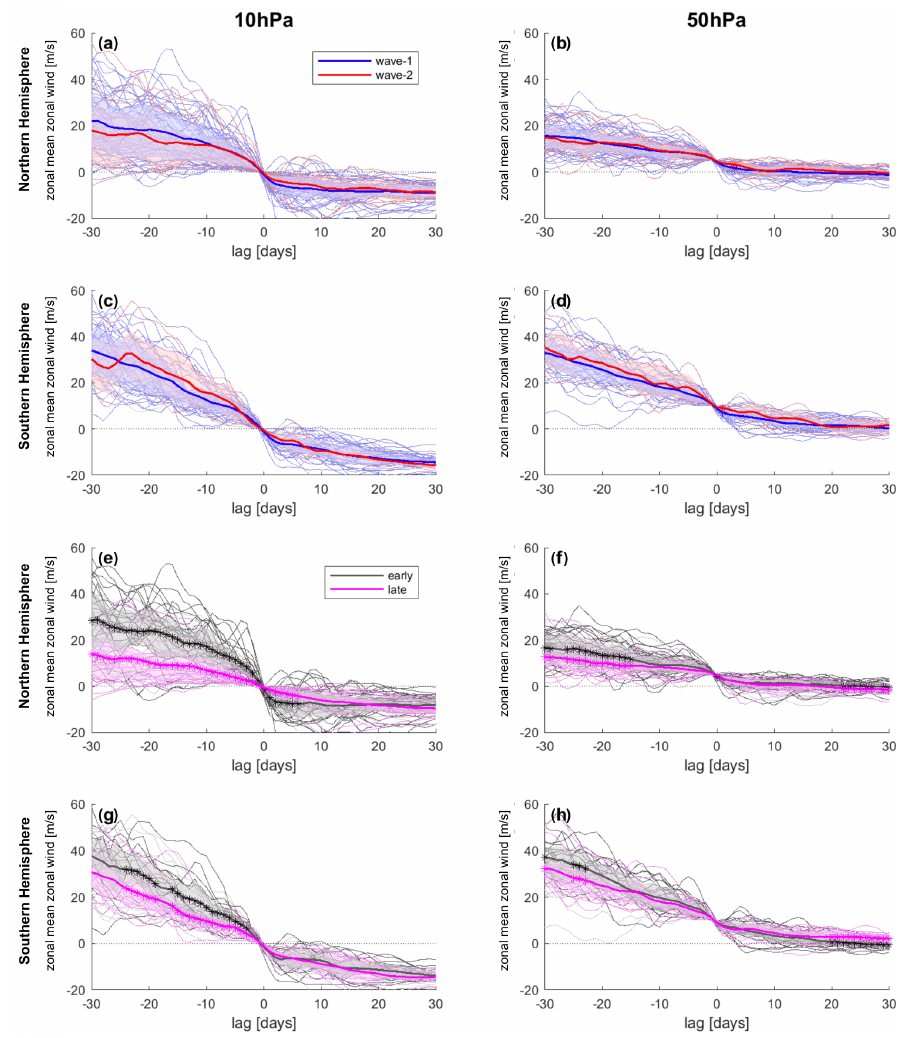
Figure 6. Composites of zonal-mean zonal wind (ms − 1 ) at 60 ◦ latitude and 10hPa (a, c, e, g) and 50hPa (b, d, f, h) for the NH (a, b, e, f) and the SH (c, d, g, h) for 1958–2019 (NH) and 1979–2019 (SH) for lags of − 30 to + 30d around all final warming event dates defined at the indicated level. (a–d) Thin blue (red) lines correspond to a wave-1 (wave-2) classification. Thin gray lines (if applicable) correspond to FSW events unclassified by wavenumber. The bold blue (red) lines indicate the average of all events classified as wave-1 (wave-2) at the depicted level. The blue (red) shading indicates the area between the 25th and 75th percentile for the wave-1 (wave-2) classification. (e–h) Same as (a–d) but for early (black) vs. late (pink) FSW events; see text for definition. Thin gray lines correspond to FSW events classified as neither early nor late at the depicted level. Stars denote lags for which the composites for wave-1 and wave-2 or early and late events, respectively, are significantly different from each other at the 95% level according to a t